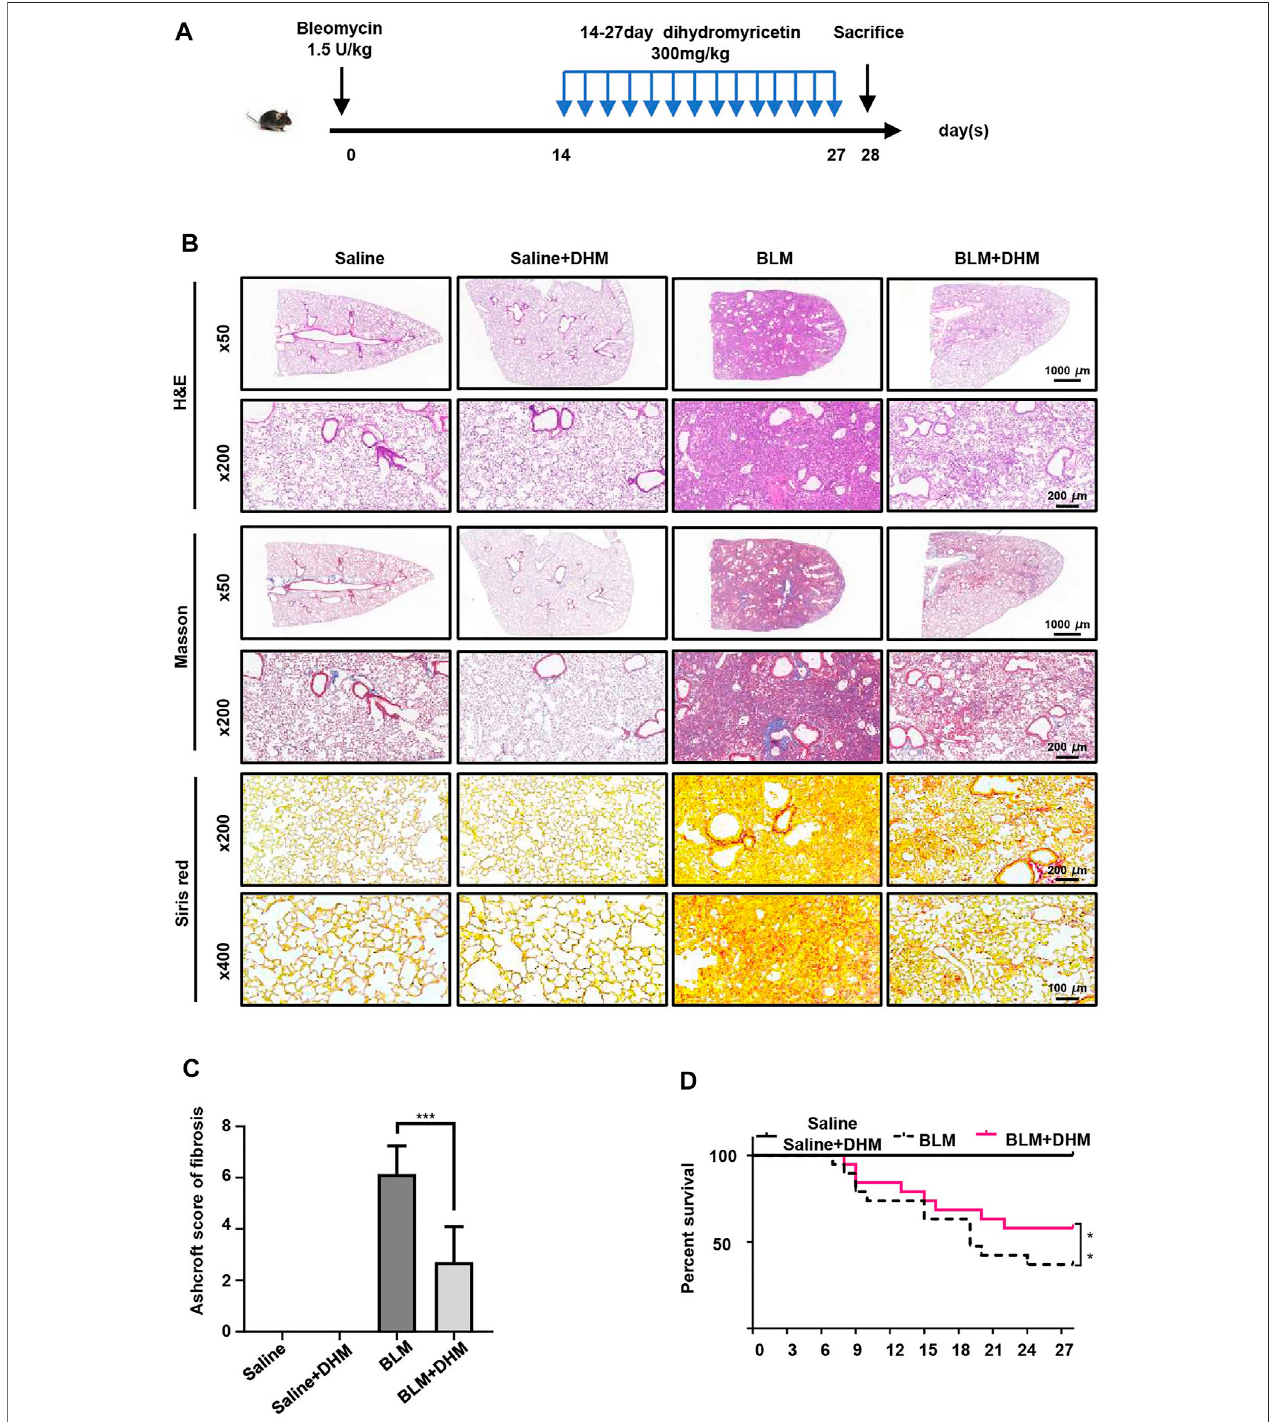
FIGURE 4 | Effects of DHM on the severity of lung fi brosis in mice after BLM induction. Saline n = 6, DHM n = 6, BLM n = 6, BLM + DHM n = 6. (A) Time course of BLM and DHM administration. (B) Histological analysis of the severity of lung fi brosis in mice after BLM induction. Images were captured at 50 ×, 200 ×, and 400 × magni fi cation. (C) Ashcroft scorein different groups ofmice ( n = 6). (D) Survivalratio in different groups ofmice. The data are represented asthe mean ± SD. Two-sided Student ’ s t-test was applied. *, p < 0.05; **, p < 0.01; ***, p < 0.001.